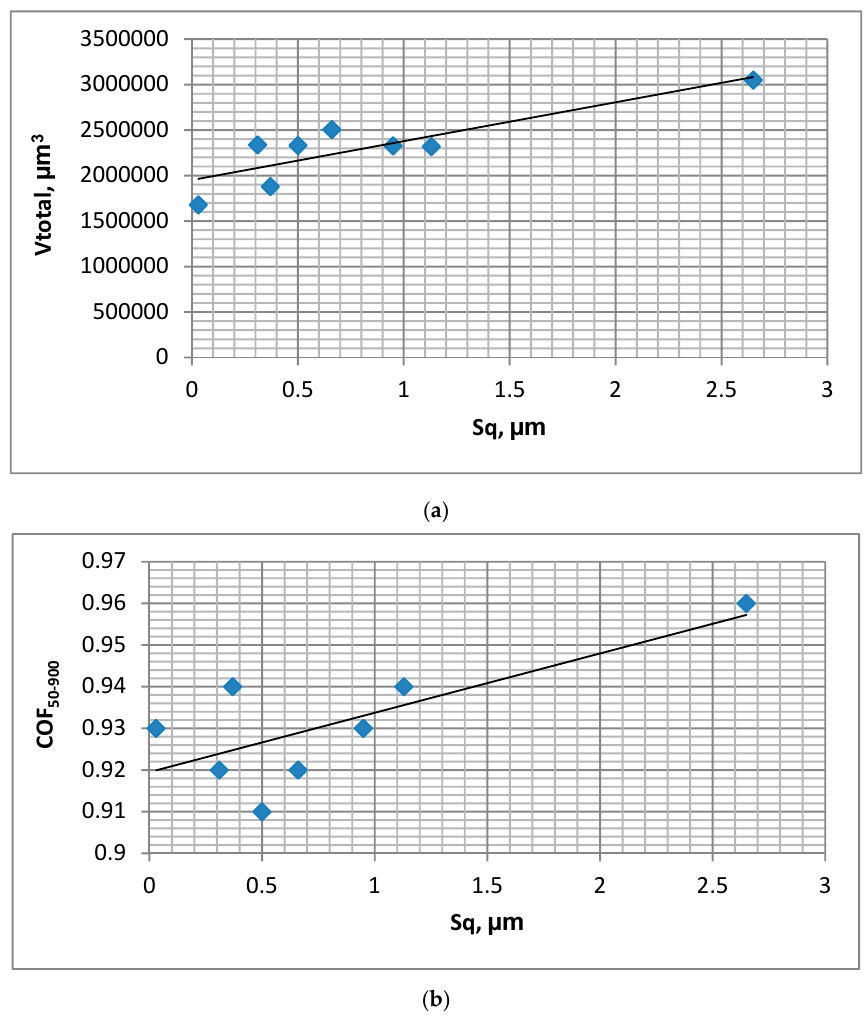
Figure 5. Dependencies between disc surface height determined by the Sq parameter and total volumetric wear of system V total ( a ) and the mean coefficient of friction ( b ) in test C: s = 0.1 mm, P = 45 N, f = 20 Hz.